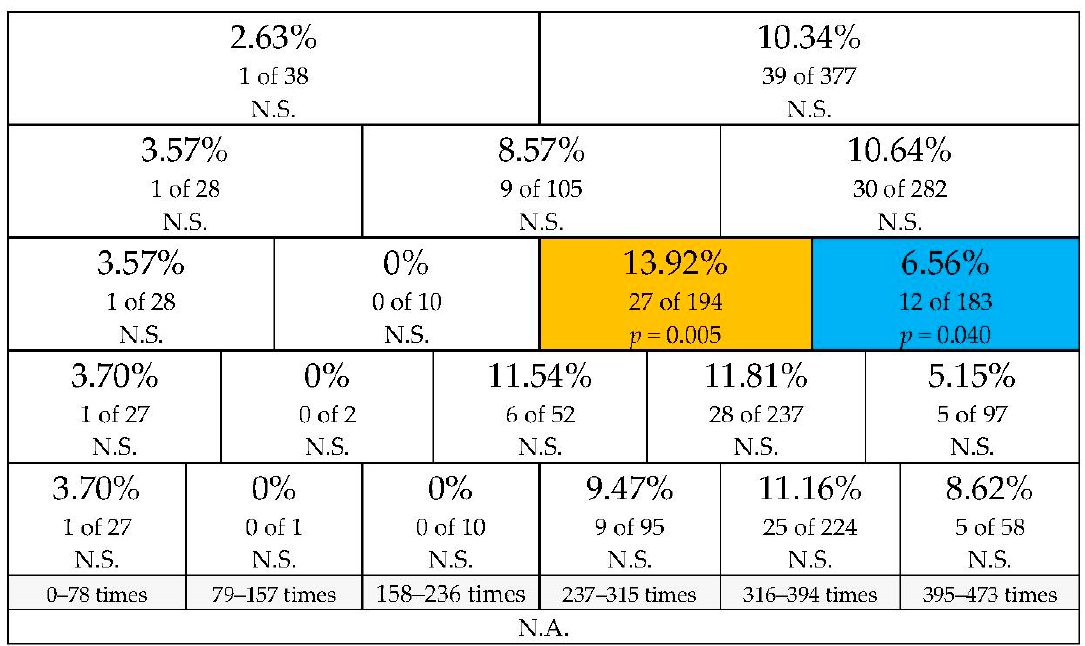
Figure 16. Entrance at yellow effect (analysis 2b). This figure shows the results when the frequency in the last 14 days is split five different ways for the subset: mean deceleration value <0.5. Percentages reflect the percentage of high values in this segment. The numbers below indicate the number of high values and the total. Orange indicates when the percentage is significantly higher than expected and blue indicates when a percentage is significantly lower than expected. White color indicates no significance. The frequency ranged from 0 to 504. The mean percentage was 1.5%. There were no signals with over three high values and a percentage above 3.0%.